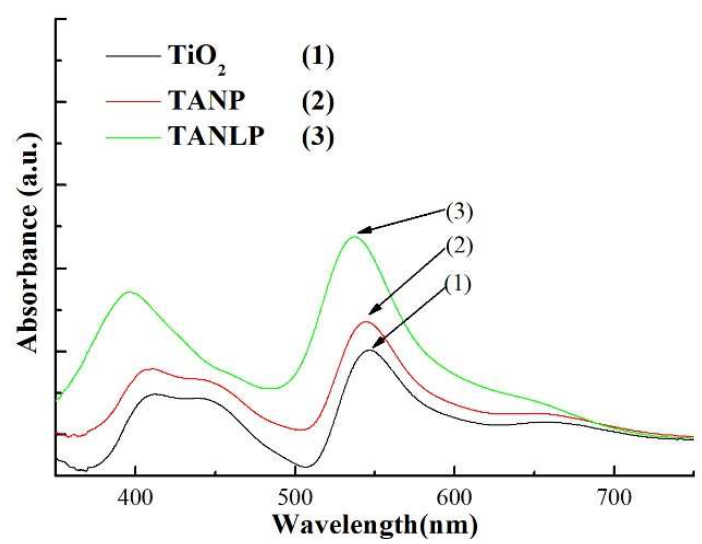
Figure 5. UV-visible absorption spectra of dye-loading of different photoelectrodes.